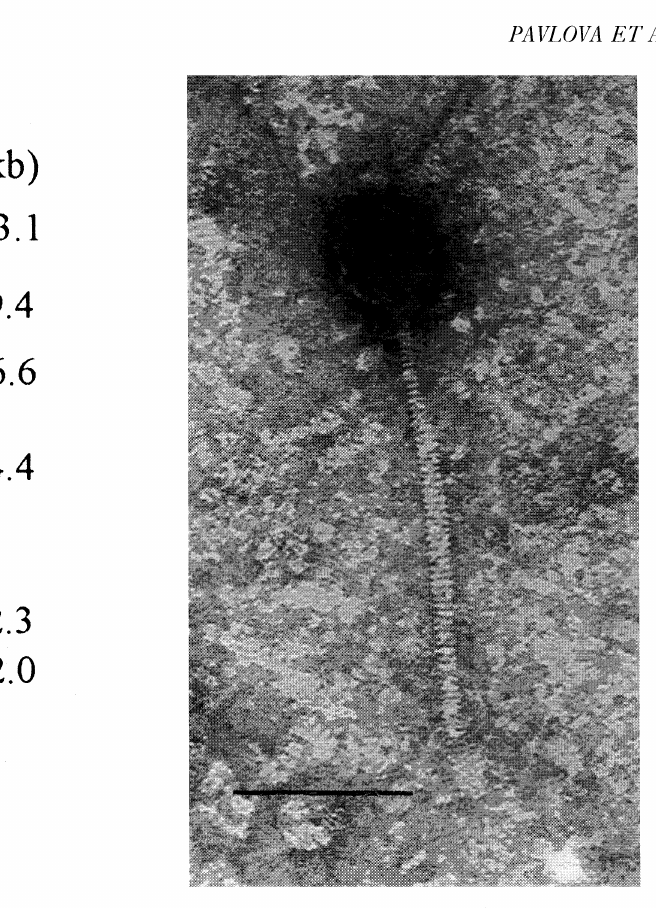
Fig. 4. Electron micrograph of the vaginal Lactobacillus phage bkc039. Stained with 2% uranyl acetate, x240,000. Bar 1,000 A (100